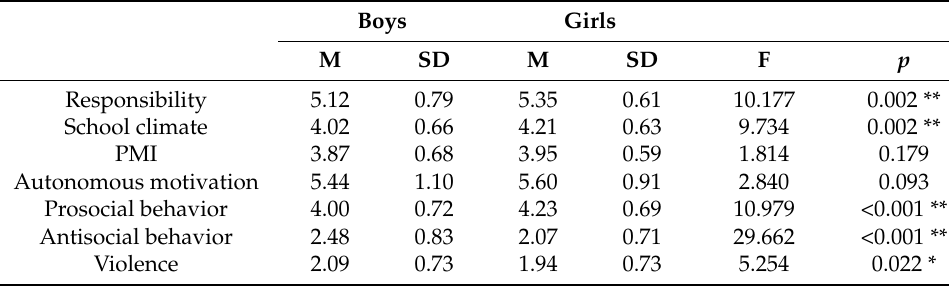
Table 3. Multivariate analysis according